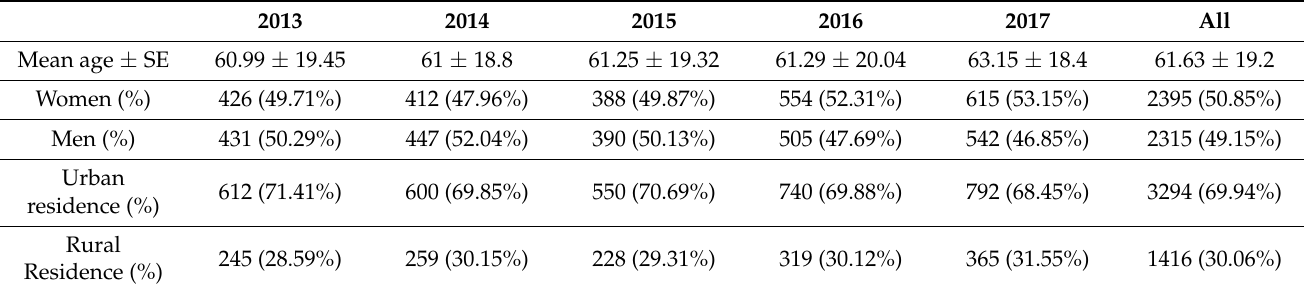
Table 2. Demographic characteristics of patients with corneal grafts in Poland during